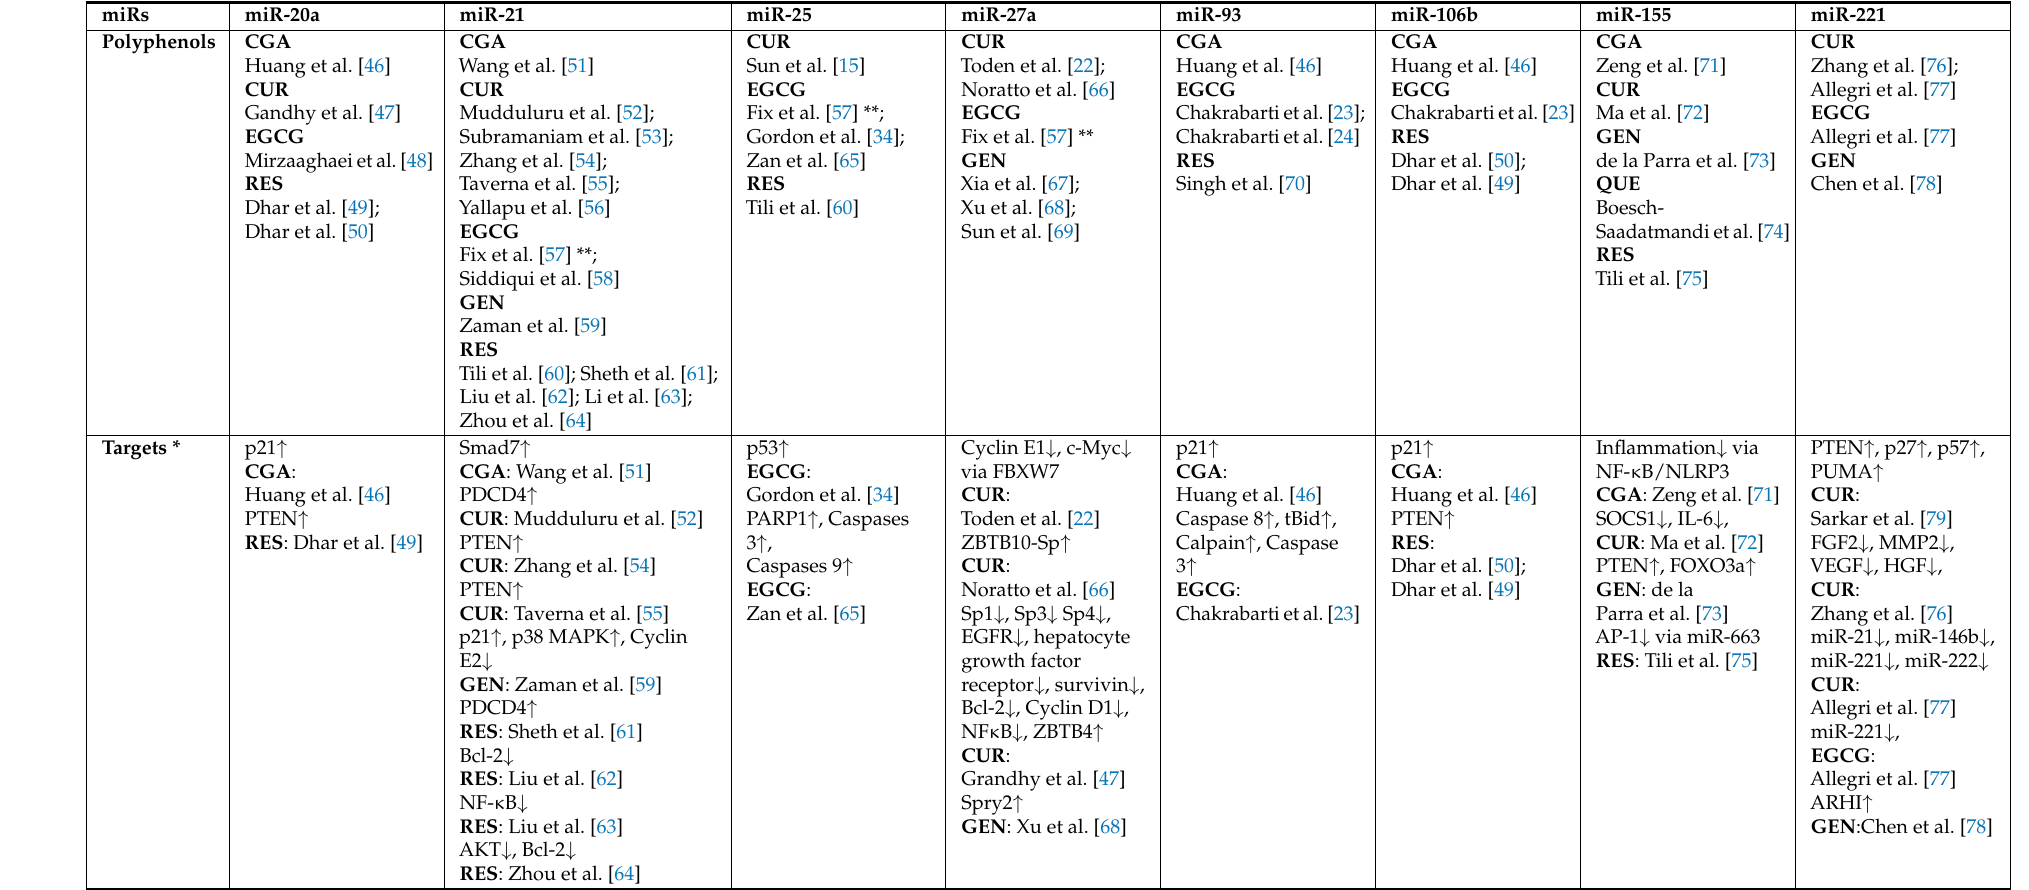
Table 2. Modulation of molecular targets of oncogenic miRs downregulated by three to five CUR, EGCG, QUE, RES and GEN. miRs miR-20a miR-21 miR-25 miR-27a miR-93 miR-106b miR-155 miR-221